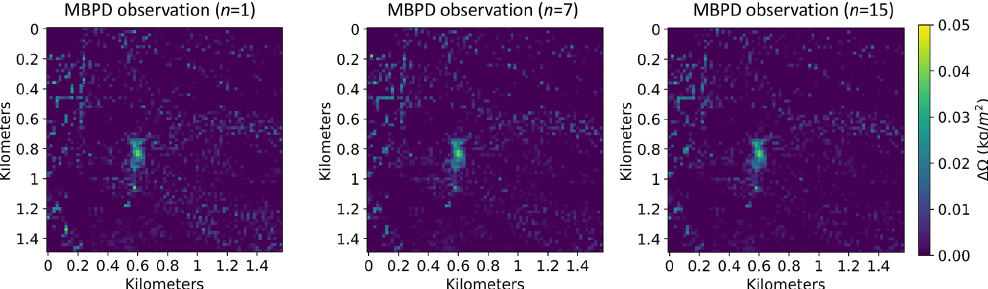
Figure 3. Examples of including multiple comparison dates. In the MBMP subtraction, we include multiple comparison dates and take their average MBSP retrievals as the subtrahend to stabilize the varying background in different dates. Here n is the number of comparison dates. From left to right ( n = 1, 7, and 15, respectively), we can see that a higher n provides a “cleaner” background in the MBPD retrieval, particularly in the lower right area, and thus increases the contrast of the